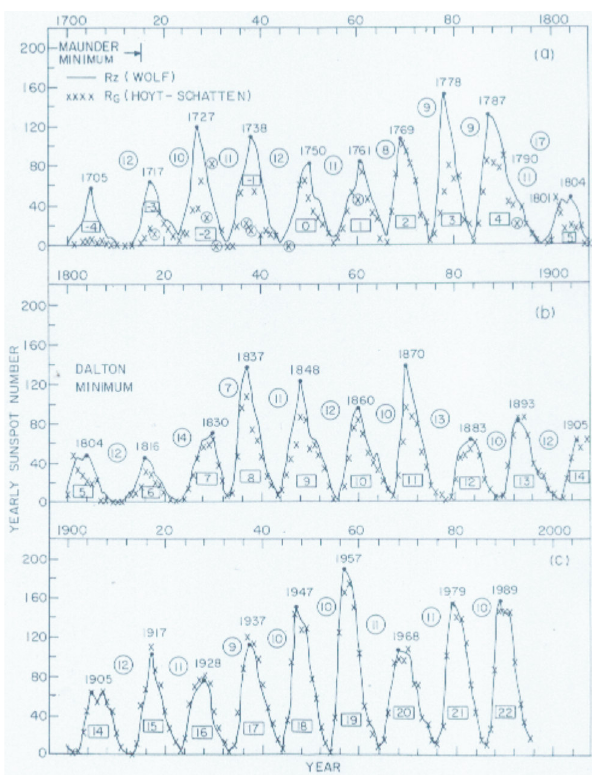
Fig. 1. Plots of annual values of Rz (full lines) and R G (crosses) for (a) 1700–1800. (b) 1800–1900, (c) 1900–1995, cycle numbers in rectangles, cycle spacings (in years, for Rz ) in Figure 1. Plots of annual values of Rz ( full lines ) and R G ( crosses ) for (a) 1700-1800. (b)2 1800-1900, (c) 1900-1995, cycle numbers in rectangles , cycle spacings (in years, for3 Rz ) in circles. 4 5